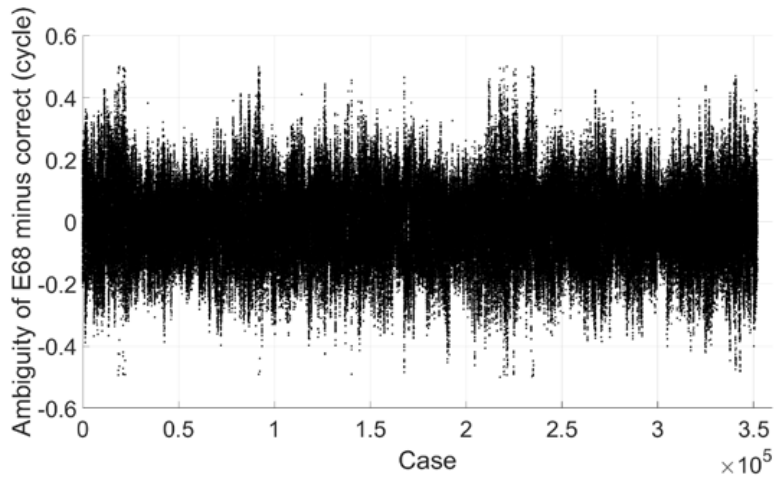
Remote Sens. 2021 , 13 , x FOR PEER REVIEW Figure 10. Extra wide-lane E68 ambiguity minus correct integer ambiguity (Galileo).